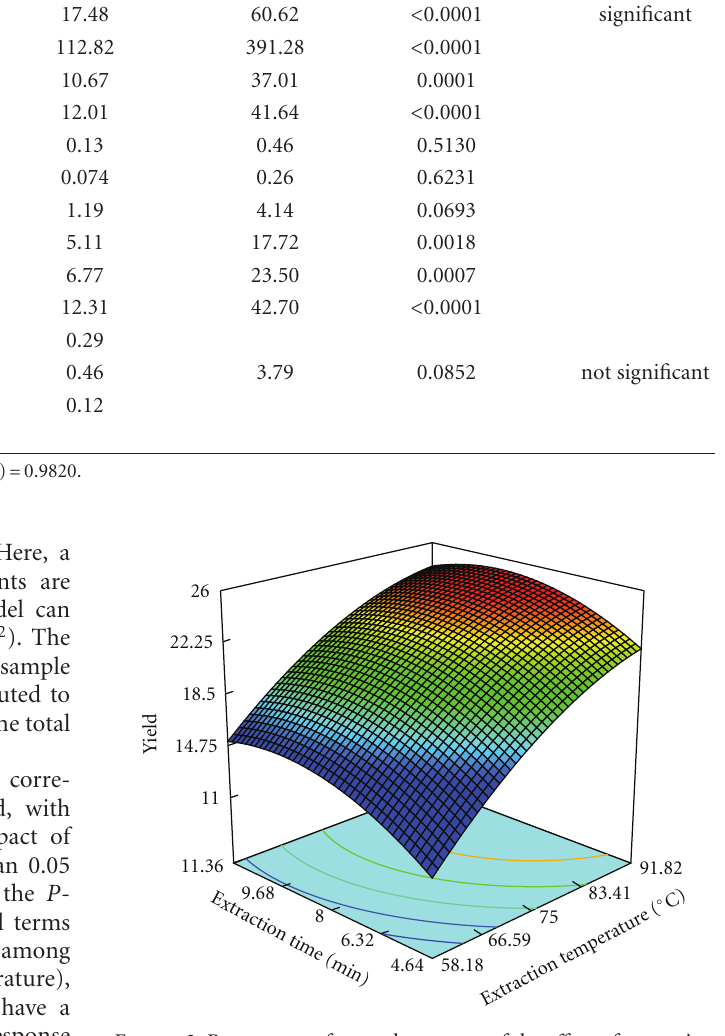
Figure 3: Response surface and contours of the e ff ect of extraction time and temperature on the yield of